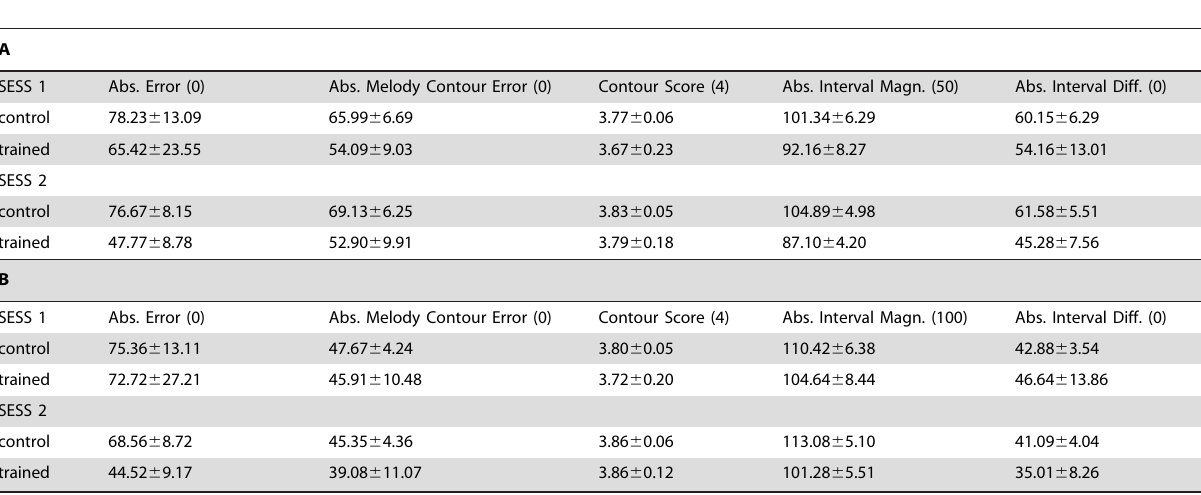
Table 2. Melodic performance measures in both groups at each